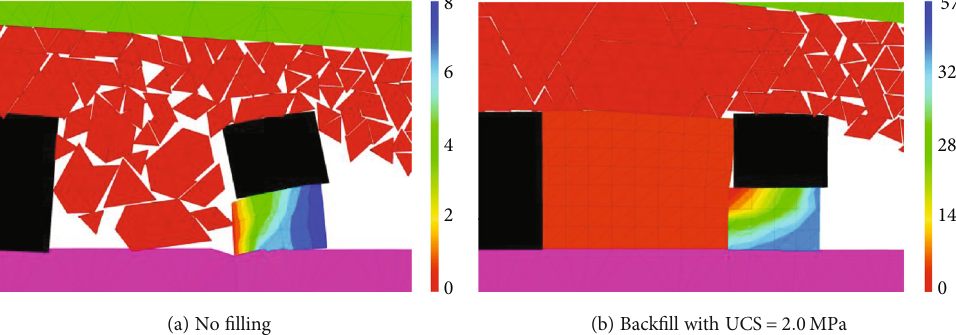
Figure 14: Deformation of the hydraulic support.